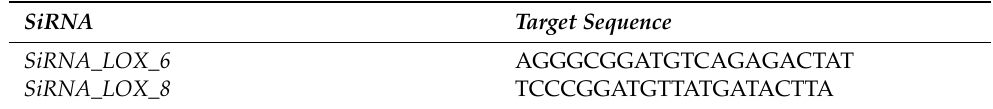
Table 3. LOX siRNAs and their target